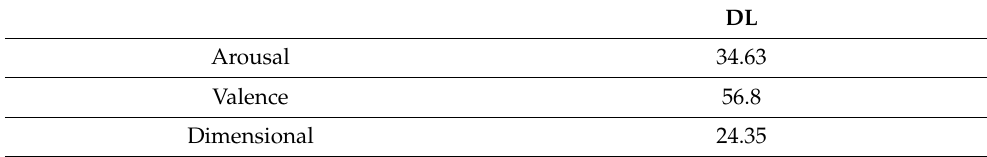
Table 9. DL model’s performance for